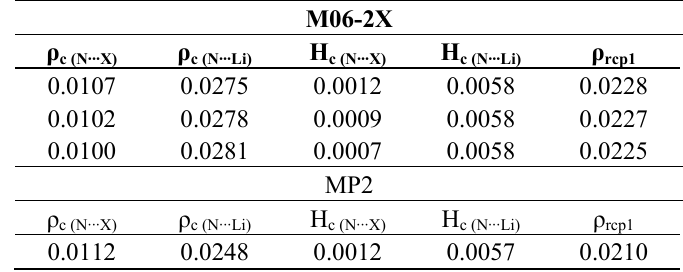
Table 5. Intermolecular bond and ring critical point electron densities ( ρ , au), and bond energy densities (H, au) in the dimers of C 1